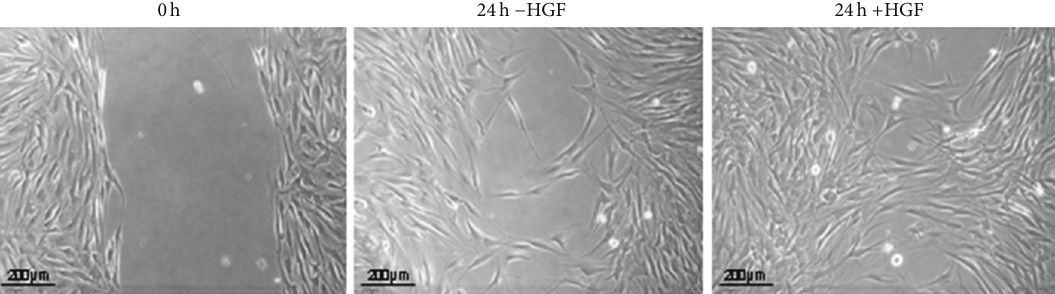
Figure 3: MSC ± HGF after 0 and 24 hours. All assays were carried out with 4 different donors in passages 2 to 5. One representative donor is shown exemplarily. Scale bars: 200 𝜇 m.